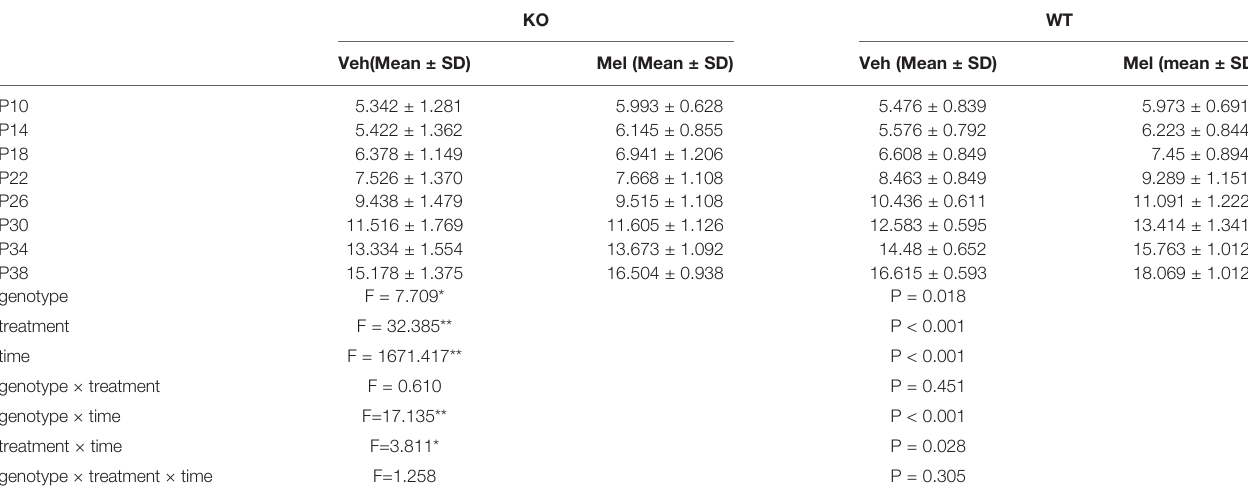
TABLE 2 | Signi fi cant results for three-way analysis of variance.